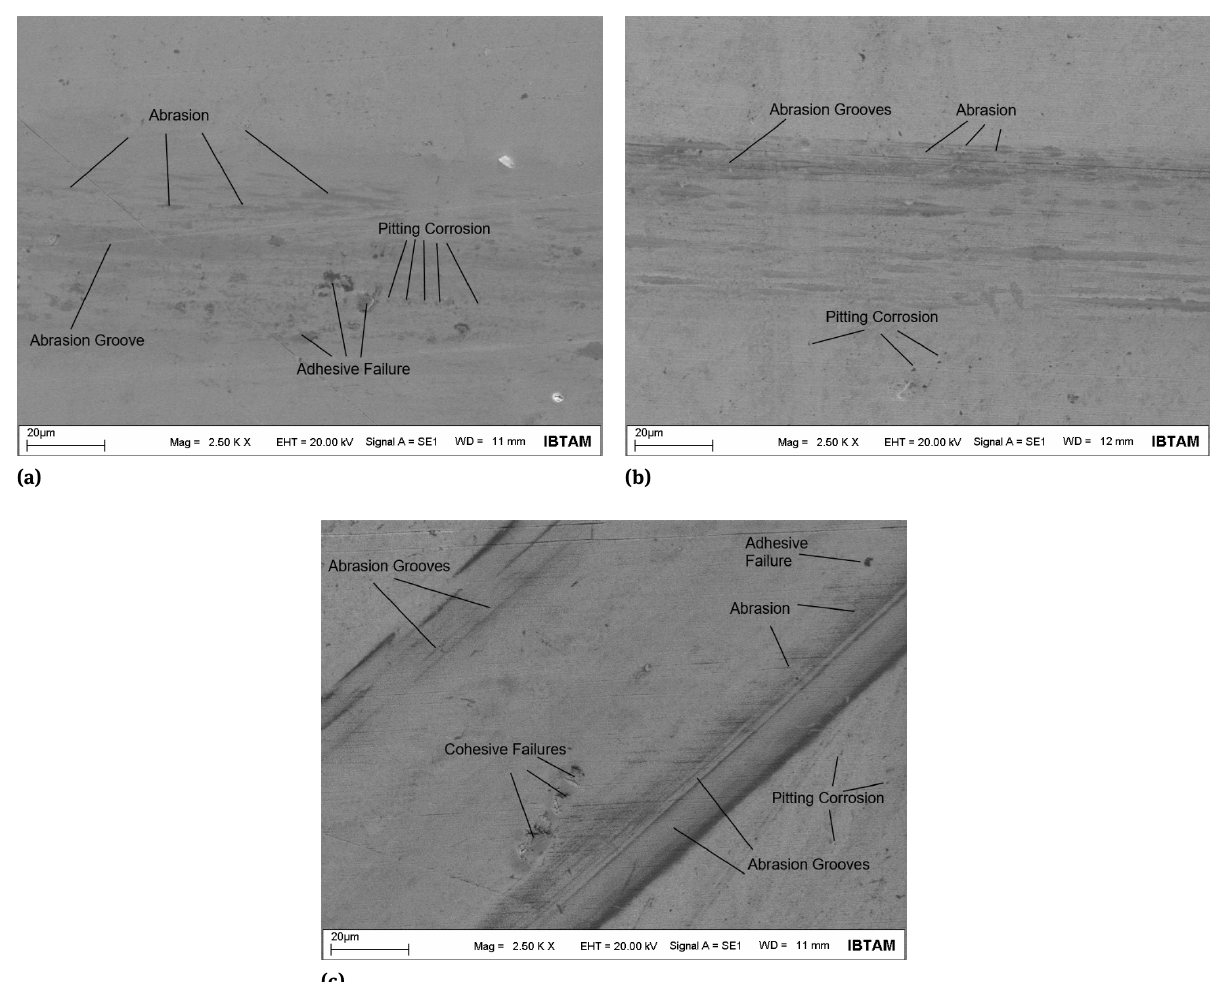
Figure 6: SEM image of worn surface of a- C1 b- C2 c- C3 Coating